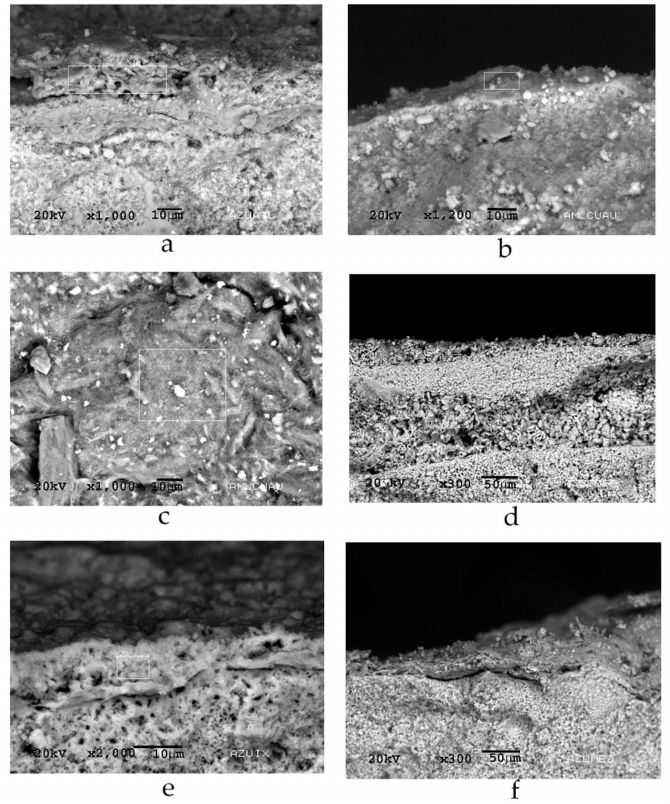
Figure 3. SEM images of different blue samples. ( a ) Atlatlaucan cross-section with three main layers. The one at the top is the paint layer that is placed over a stucco and, on the bottom, the plaster can be seen. ( b ) Cuauhtinchan, cross-section with three main layers. The one at the top is the paint layer that is placed over a thin white layer of stucco placed over a plaster. ( c ) Cuauhtinchan, surface of the pain layer, a mesh of thin needle-shaped features can be seen. ( d ) Cuernavaca cross-section. The pigment is dispersed within the surface layer, where dark areas can be observed. The pictorial layer is placed over several layers of gypsum. ( e ) Ixmiquilpan, cross-section. The top layer is the blue paint placed over a thin white layer made of gypsum, and on the bottom, the plaster is observed. ( f ) Meztitl á n, cross-section. The paint layer is placed directly over a